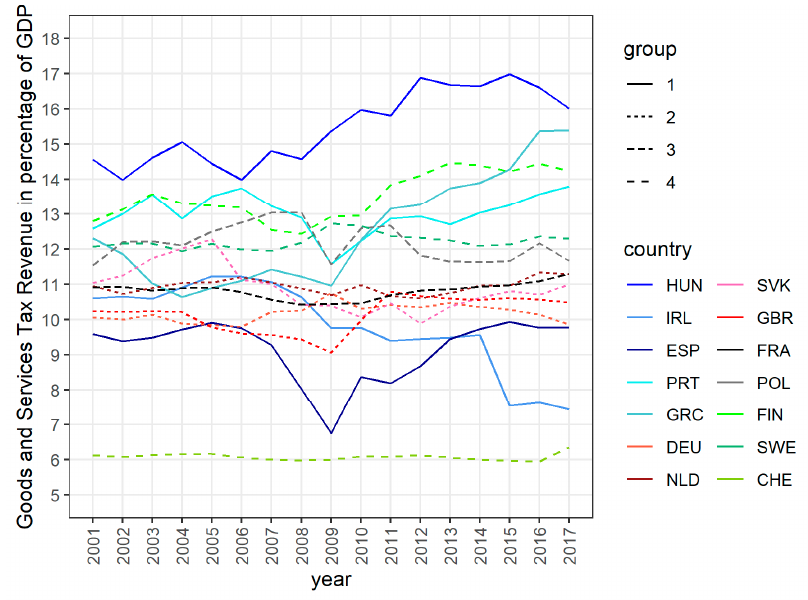
Figure 9. The development of the goods and services tax revenues in analyzed countries.